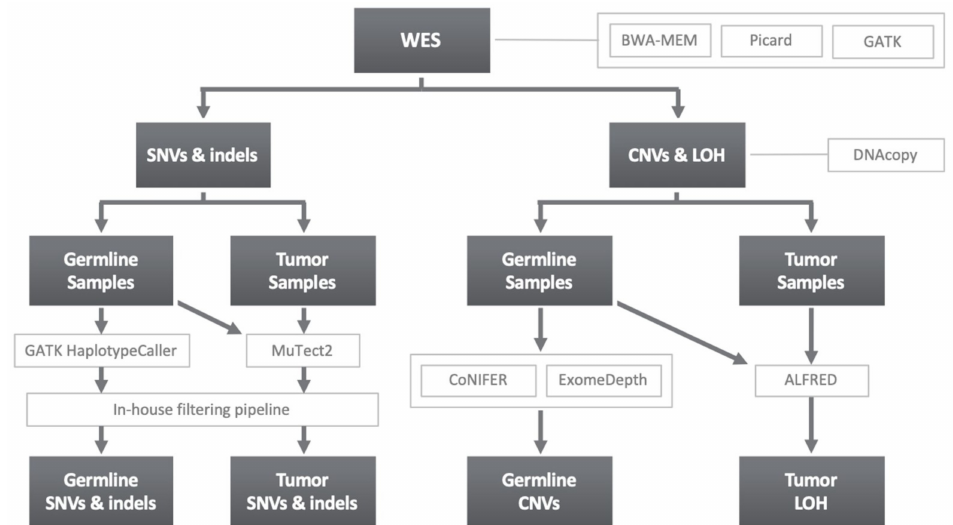
Figure 2. Methodology schematic for variant identification, showing the software used in each analysis step for the different classes of genetic variation considered. WES, whole-exome sequencing; BWA-MEM, Burrows-Wheeler Alignment Tool; GATK, Genome Analysis Toolkit; SNV, single nucleotide variant; indels, insertion and deletion variants; CNV, copy number variant; LOH, loss of heterozygosity; MuTect2, somatic SNV and indel variants